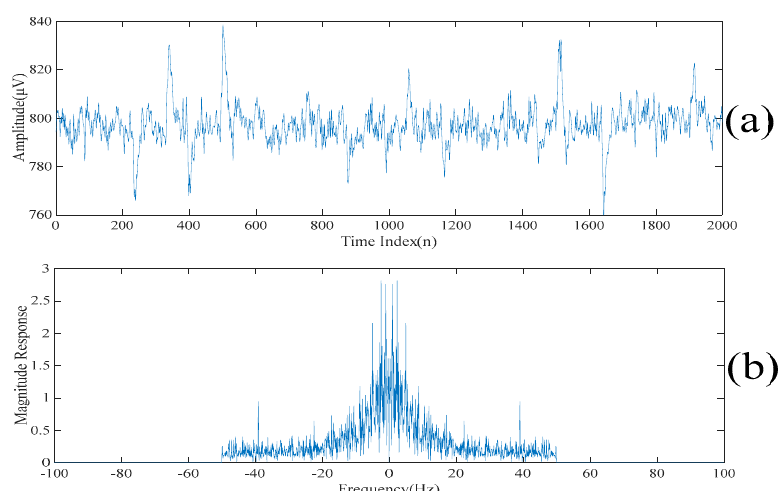
Figure 4. ( a ) The impulsive response of the filtered electroencephalogram. ( b ) The magnitude response of the filtered electroencephalogram.